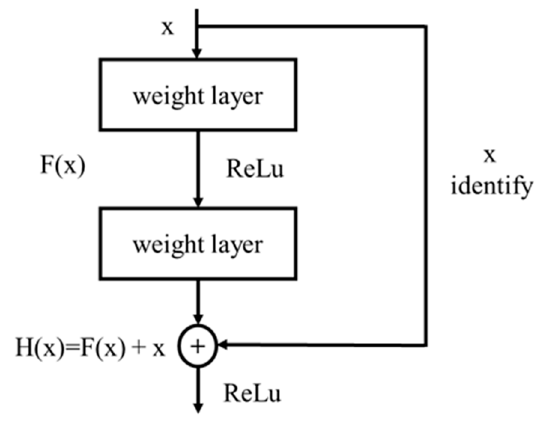
Figure 3. A block in a deep residual network [20].